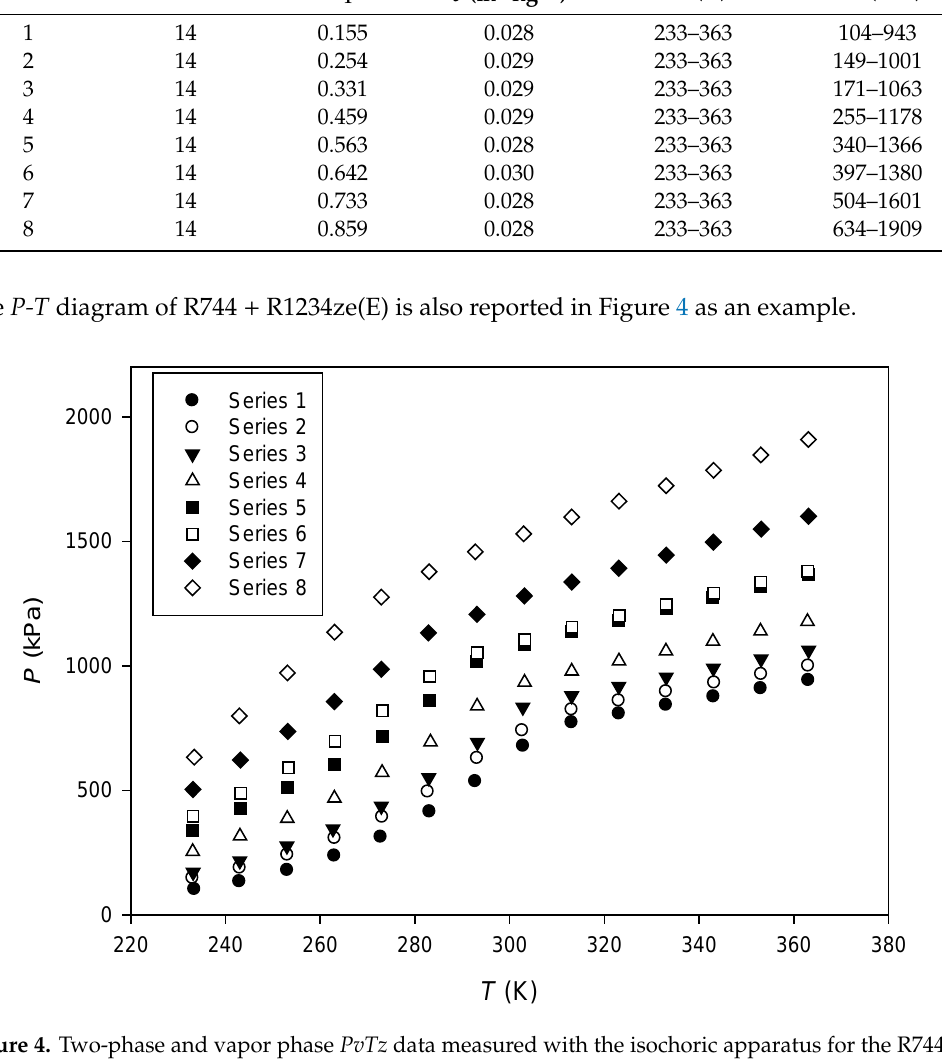
Figure 4. Two-phase and vapor phase PvTz data measured with the isochoric apparatus for the R744 + R1234ze(E) binary system. Table 2. Measurements at bulk compositions z 1 and average specific volumes v for R744 (1) + R1234yf (2) binary system over the temperature range ΔT and pressure range ΔP .